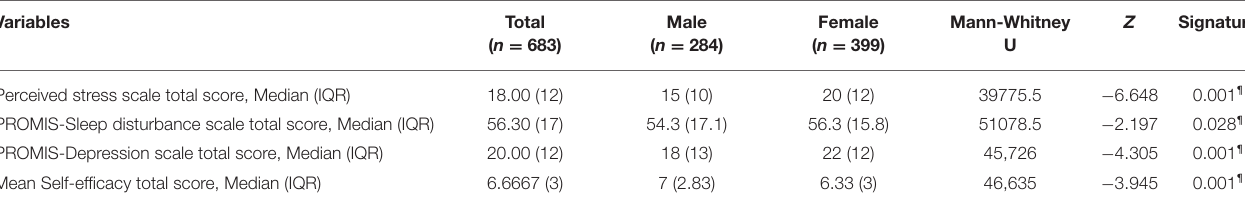
TABLE 2 | Prevalence of perceived stress, sleep disturbance, depression, and self-efficacy stratified by gender ( N =